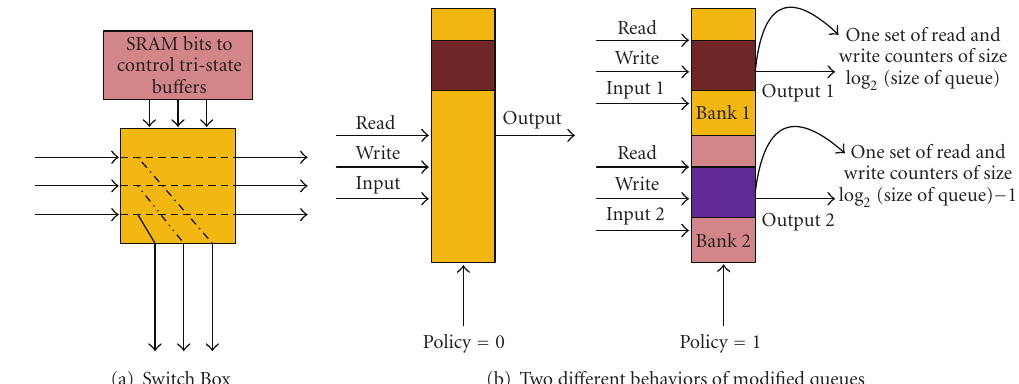
Figure 9: Two major components used for reconfigurable logic between clusters.